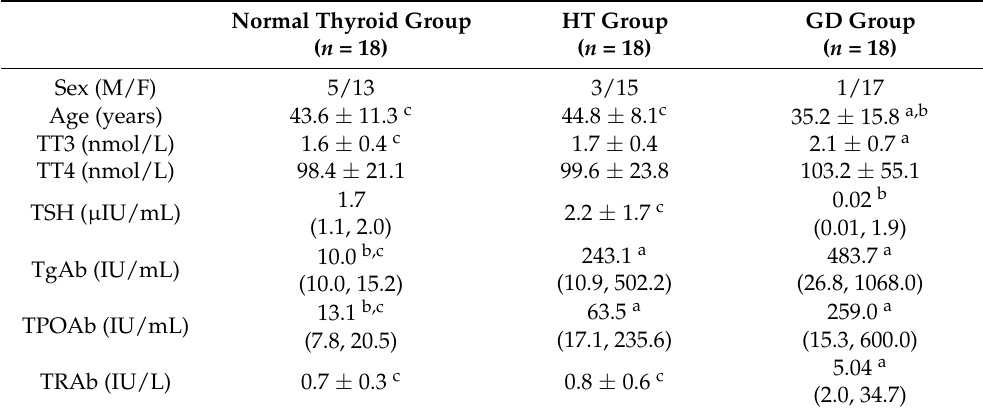
Table 1. Demographic characteristics and clinical features of the HT, GD, and normal thyroid